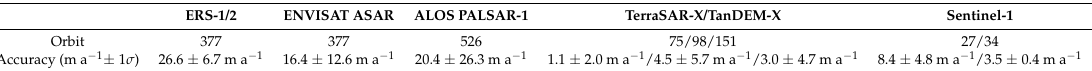
Table 2. Accuracy of surface velocities (m a − 1 ) and standard deviation (sd) ± 1 σ , averaged for each sensor and